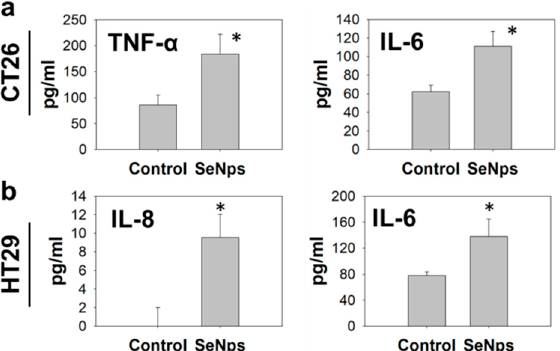
Figure 7. Colon cancer cells secrete pro-inflammatory cytokines upon treatment with SeNps. ( a ) Secretion of TNF ‐α or IL ‐ 6 from SeNps ‐ treated CT26 cells and ( b ) IL ‐ 6 or IL ‐ 8 from SeNps ‐ treated HT29 cells. Cells were treated with 15 μ g/mL SeNps for 3 h. Quantification of cytokine levels in culture supernatants was performed by ELISA. Results are presented as the mean value ± S.D. of two independent experiments (* p < 0.05, Student’s t ‐ test).